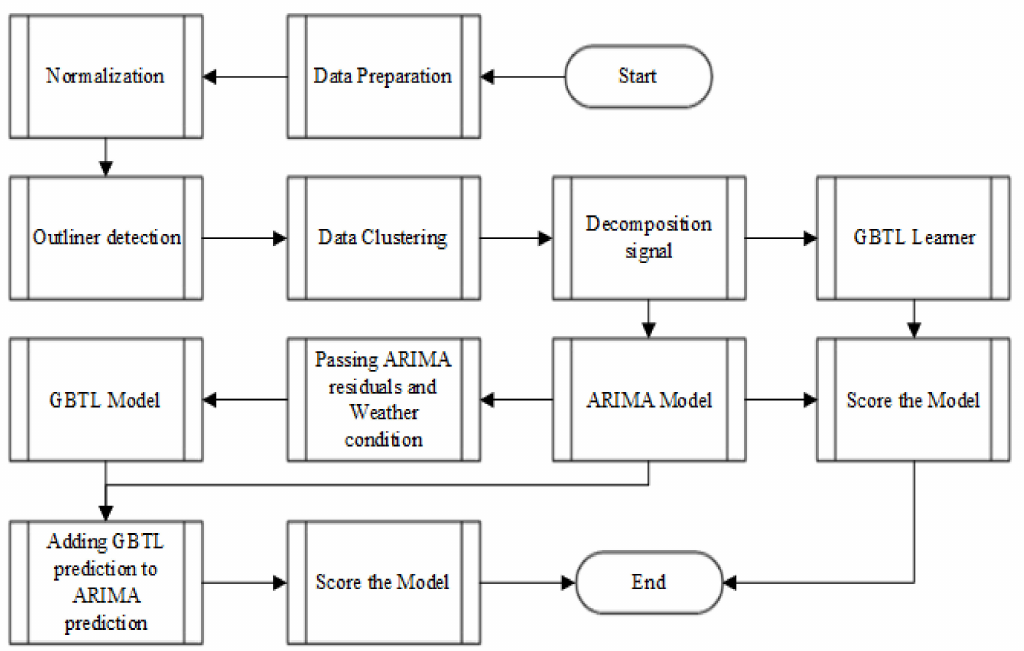
Figure 3. PIAS Data Analytics Process